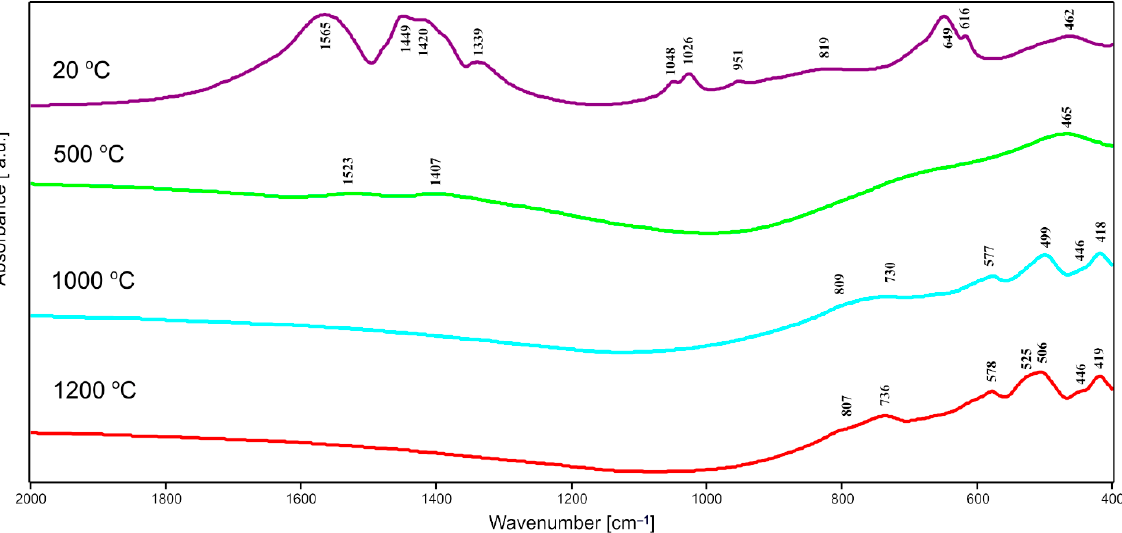
Figure 4. FTIR spectra of pure ZrO 2 (4% mas. ZrO 2 ), synthesized using zirconium (IV) n-propoxide and annealed at 500 °C, 1000 °C, and 1200 °C in air.